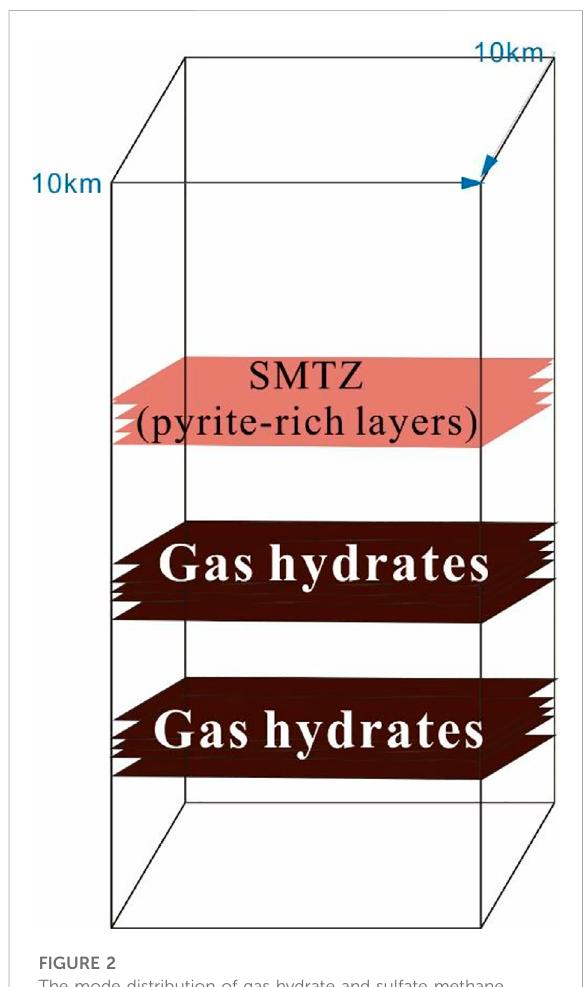
FIGURE 2 The mode distribution of gas hydrate and sulfate methane transition